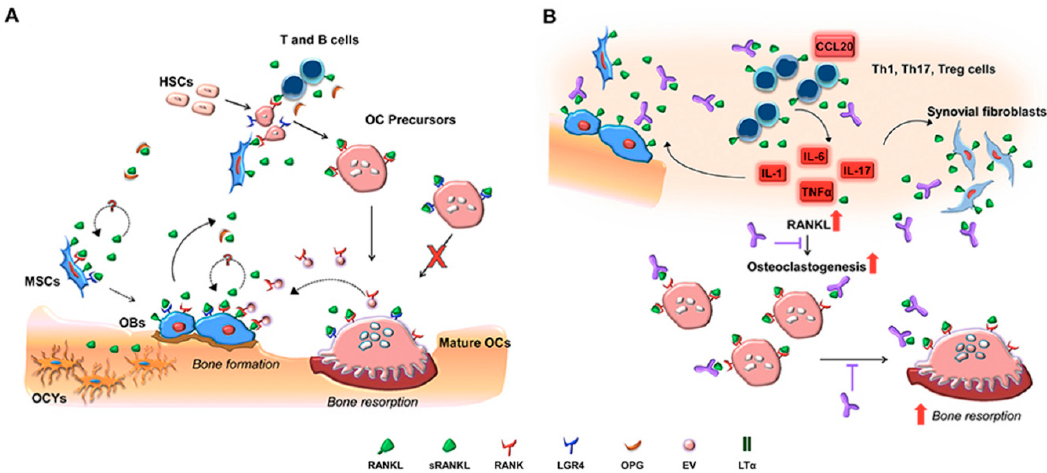
Figure 2. Diagrammatic illustration of molecular and cellular players taking part in RANK, RANKL, and OPG signaling in bone during physiological ( A , B ) pathological conditions. Soluble RANKL synthesized by osteoblasts and immune cells induce osteoclastogenensis when attaching to RANK on osteoclast precursors [35]. OPG is the soluble decoy receptor for RANKL. The expression of RANK by mesenchymal stem cells and osteoblasts points to a potential RANKL autoregulatory mechanism affecting bone deposition. Furthermore, extracellular vesicles (EV) initiate a reverse signaling on osteoblast ( B ), depicting enhanced synthesis of RANKL by immune cells and osteoblastic cells [35]. This exaggerates osteoclast generation and bone loss. Image adapted with kind permission from the publisher. On the other hand, it was also revealed that the gene family with IL-1 cytokine had three different members with different receptor antagonist: IL - 1 β , IL - 1 α , and IL - 1 [36]. The catabolic events of these cytokines are managed through endogenous inhibitors that embody IL-1 and TNF receptor antagonists. When administered for healing capabilities, those antagonists can decrease infection [37]. Using the receptors from a particular cytokine tends to limit pathogens from developing further disease progression. This means that the processes of developing effective interventions on therapeutic modalities will require thorough investigations to gain insights on the available inflammatory mediators as well as other factors that need to be elucidated. In conclusion, using cytokine antagonists to treat PD in this scope needs to be further examined properly to obtain conclusive and effective treatment modalities. Recently, Rath-Deschner et al. reported higher levels of CXCL 1 (motif chemokine ligand 1), CCL 2 (motif chemokine ligand 2), and CCL 5 (motif chemokine ligand 5) chemokines in vitro and in vivo in human and rat gingiva in sites with periodontitis [38]. CXCL 1 , also known as GRO-alpha, is a potent chemoattractant for neutrophils [39], whereas CCL 2 and CCL 5, also known as MCP-1 and RANTES, are primarily responsible for the recruitment of monocytes, macrophages and T-lymphocytes [38]. 2.2. Pathways of Tissue Destruction via MMPs In zinc-dependent proteolytic enzymes and their related families, matrix metalloproteinases (MMPs) play a crucial role in regulating pathophysiological and physiological processes in repairing damaged tissues, reshaping of cytokines, remodeling extracellular matrix, and activating defensins and mediators [40] MMPs also mediate and regulate immunomodulatory responses by releasing cytokines that prioritize growth factors in favor of cells and tissues, as well as modify nonmatrix substrates such as chemokine to enhance the healing processes [41]. MMPs can also be indicated in any issue that is related to the destructive tissues and/or pathological conditions, as well as periodontitis defensive processes, wound healing, etc. This is specifically related to MMP-2, -9, and -8 [41]. Besides, MMPs share a common gene with at least 24